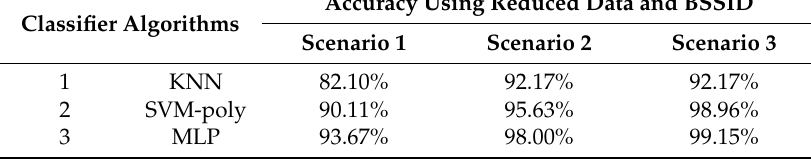
Table 2. Localization performance through